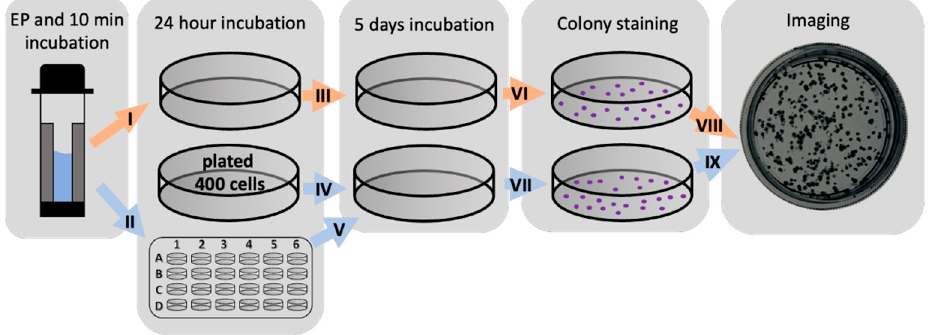
Figure 6. Visual representation of cell viability evaluation after direct (orange arrows) and indirect (blue arrows) treatments.